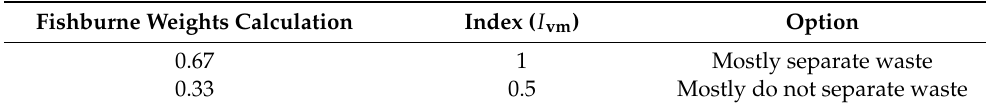
Table 14. Index system for waste separation.